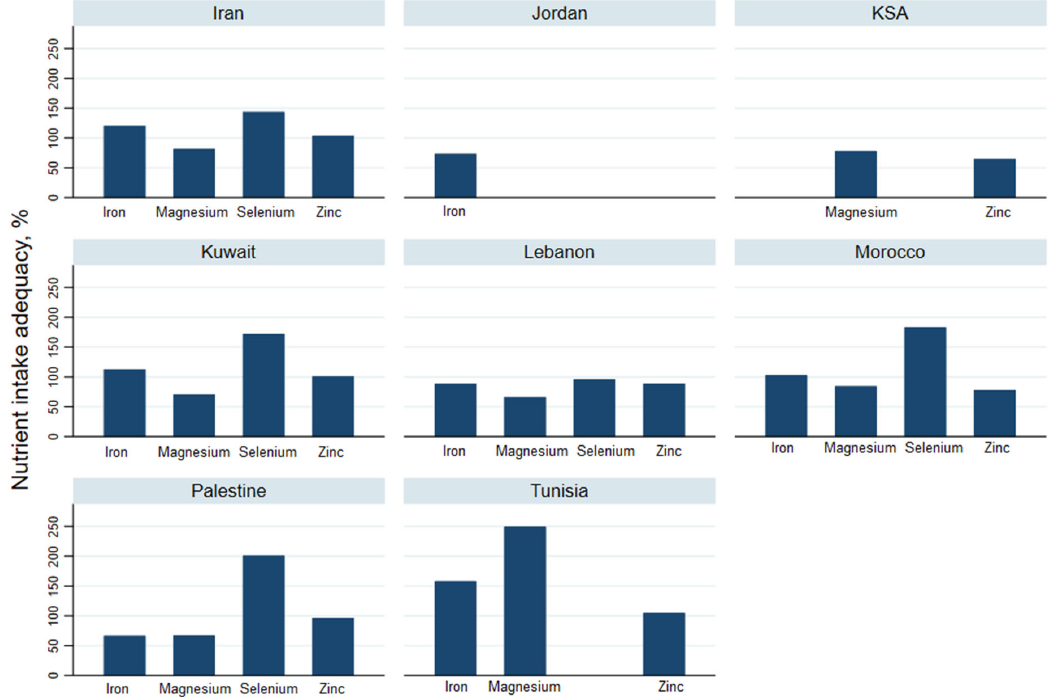
Figure 3. Adequacy of trace elements intake for people in the countries sampled in the Eastern Mediterranean Region.